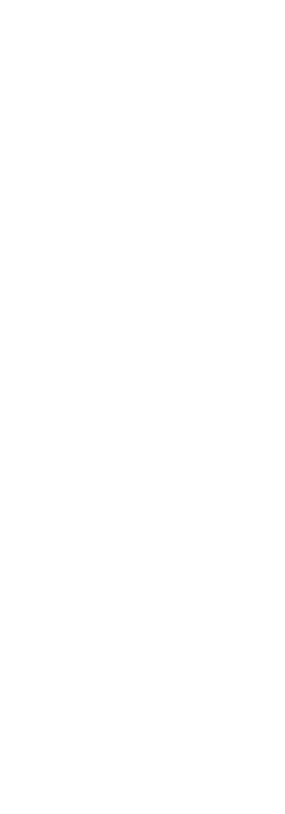
FIGURE 9 | The predictive roles of the ICI signature in immunotherapy. (A) Correlations between the risk scores and immunotherapy responses in IMvigor210. (B) Kaplan-Meier curve of the high-risk and low-risk patients in IMvigor210. (C) The relationship between the risk scores and immunophenoscores (IPS) in the four subgroups based on CTLA4 and PD1 status in TCIA database. (D) ROC curves of multiple signatures for the 7-year survival